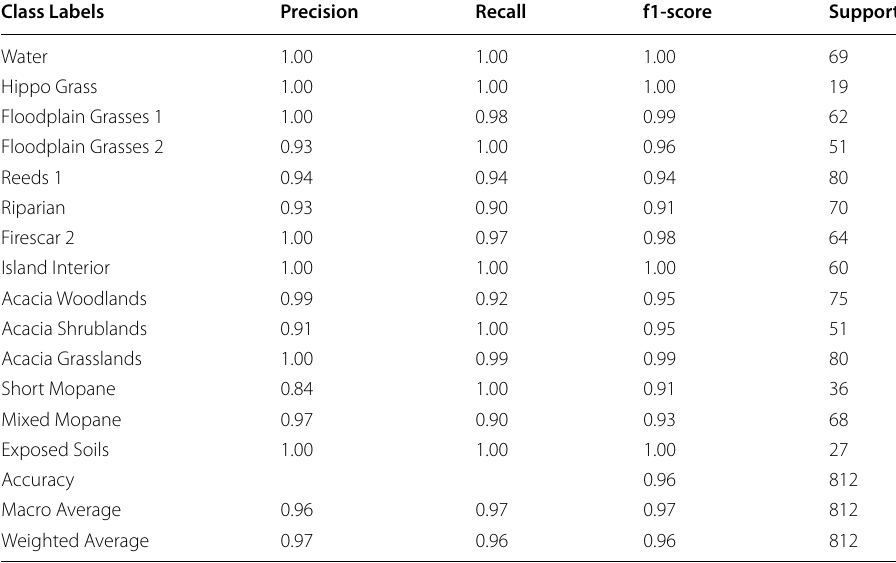
Table 16 Detailed classification test results for the Botswana Dataset in terms of Precision, Recall, and F1-Score. Testing was done with PCA 30 CEU-Net no-patching with a 75%/25% Training/Testing split Class Labels Precision